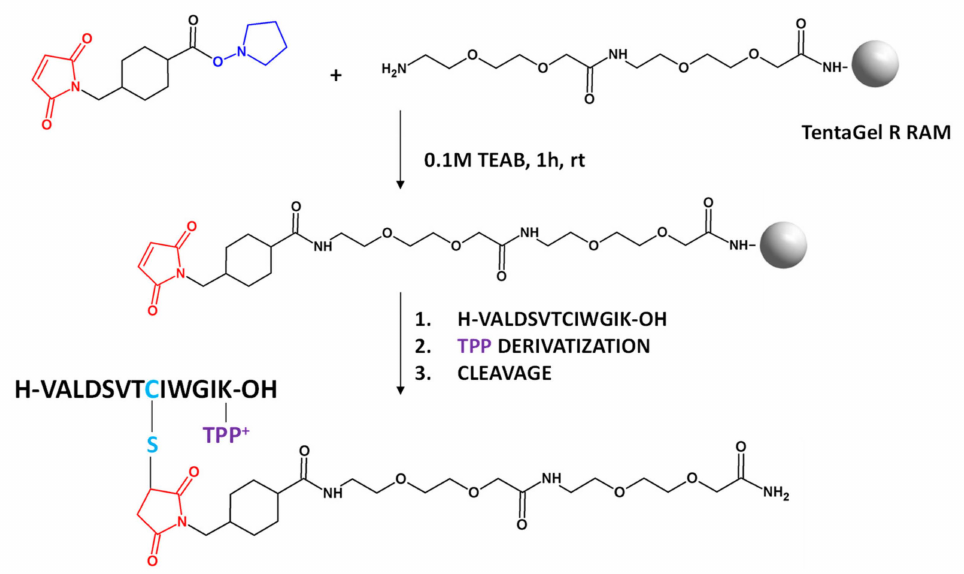
Figure 2. Schematic presentation of the TentaGel R RAM resin preparation, capturing cysteine- containing peptides, and their derivatization by a fixed charge tag in the form of